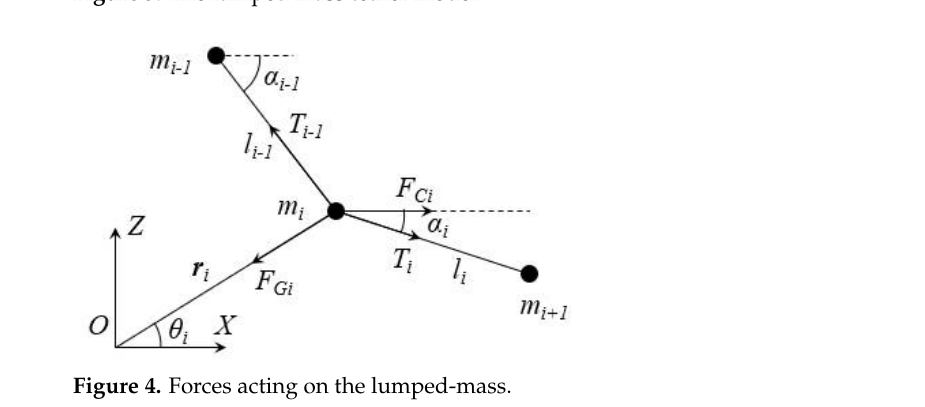
Figure 3. The lumped mass tether model.